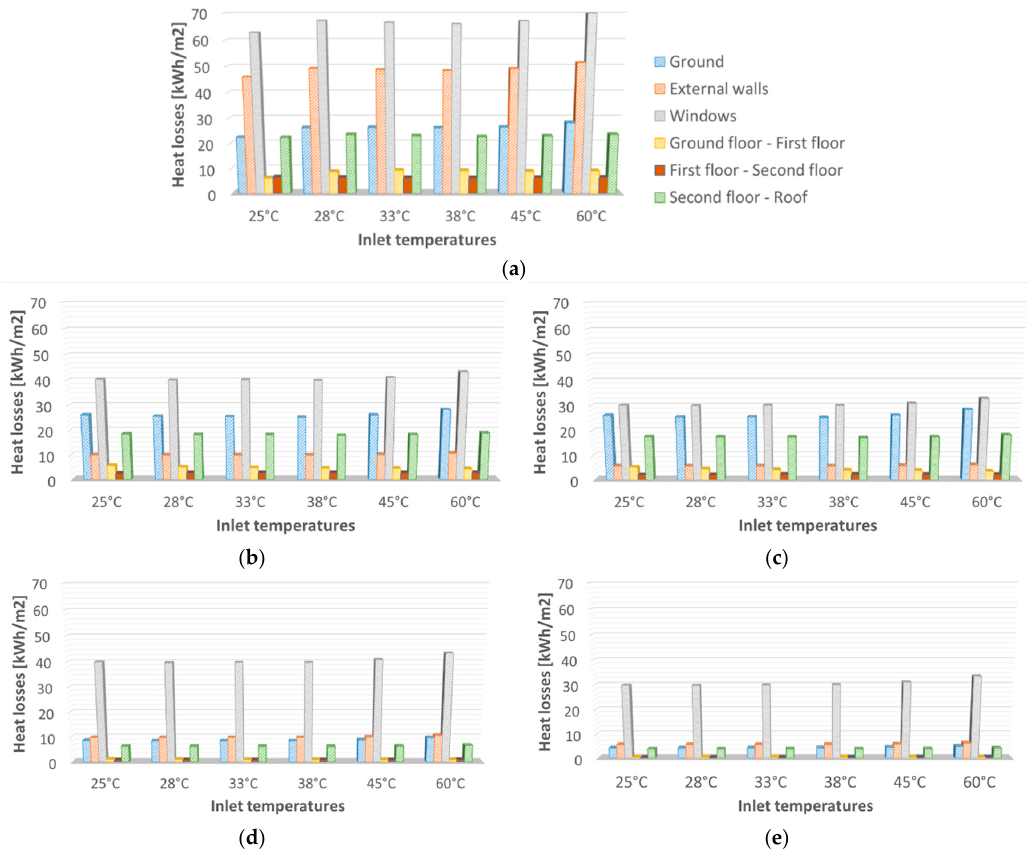
Figure 9. Heat losses through each surface of buildings with different renovation scenarios in a winter period in Potsdam. Ground: heat losses through the ground floor to ground; External walls: Heat losses through facades; Ground floor–First floor: heat exchange between the ground and first floor); First floor–Second floor: heat exchange between first and second floors; Second floor–Roof: Heat losses from the second/last floor to ambient through the roof. ( a ) Reference building: without renovation; ( b ) Partly renovation (EnEV standard); ( c ) Partly renovation (Passive House standard); ( d ) Ambitious renovation (EnEV standard); ( e ) Ambitious renovation (Passive House standard).